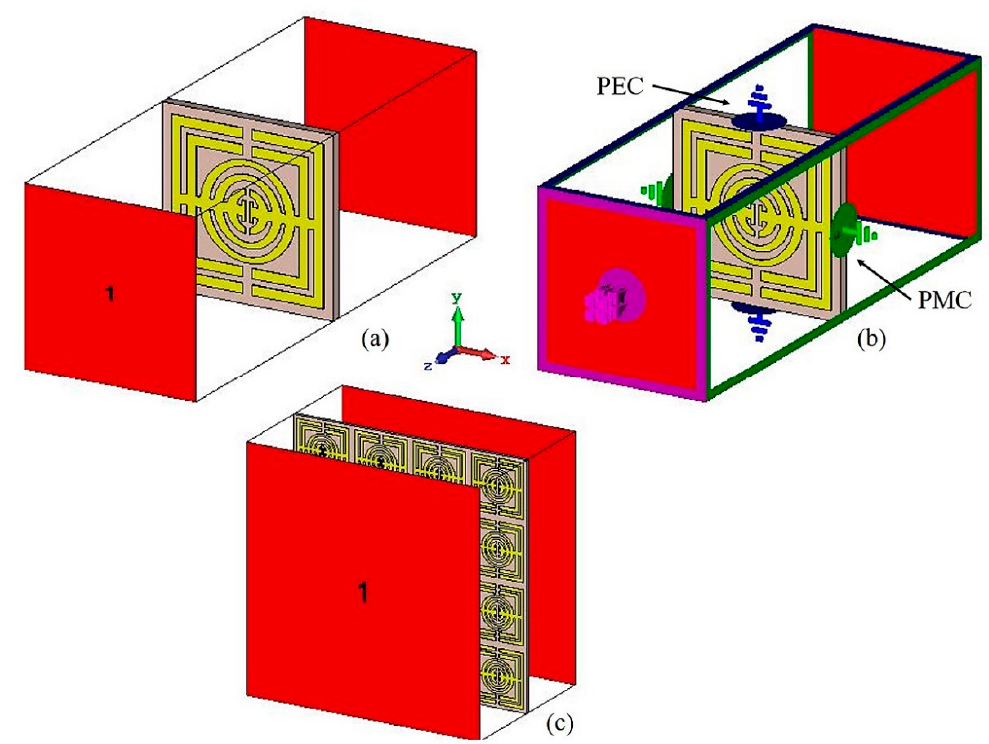
Figure 2. Wave propagation simulation, ( a ) unit cell metamaterial, ( b ) boundary conditions, and ( c ) 4 × 4 arrays metamaterial.